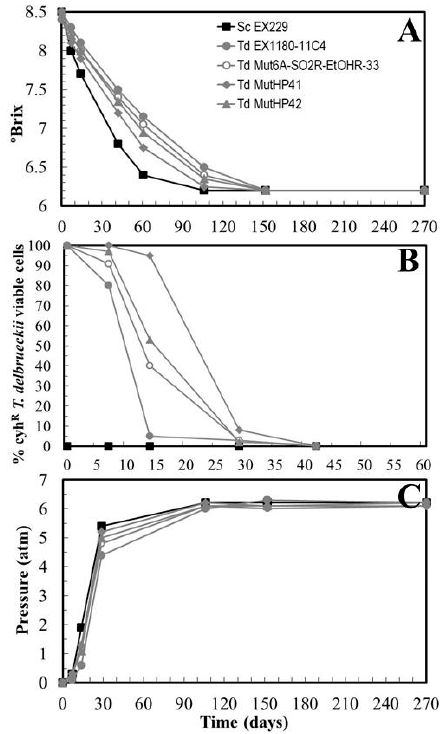
Figure 7. Fermentation kinetics and yeast population dynamics during sparkling wine second-fermentations inoculated with selected T. delbrueckii HP R mutants. Macabeo base wine was single inoculated with Sc EX229, Td Mut6A-SO2R-EtOHR-33, Td MutHP41, or Td MutHP42. ( A ) Evolution of sugar consumption (Degrees Brix). ( B ) Percentage of cyh R yeast cells in each fermentation. ( C ) Pressure inside the bottle. Data are the mean values of three fermentations inoculated with each yeast strain. Standard deviations were less than 15% of the means.